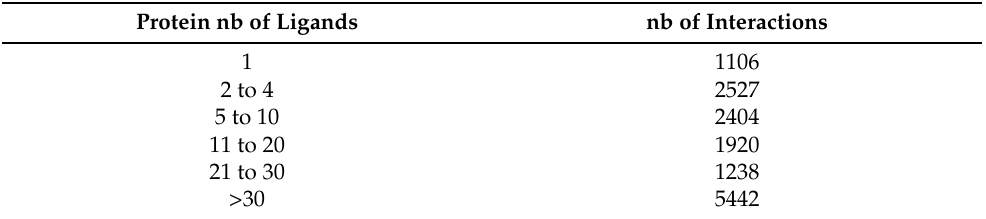
Table 2. Distribution in the DB-Database of the number of DTIs involving proteins from various categories, according to their number on known ligands.